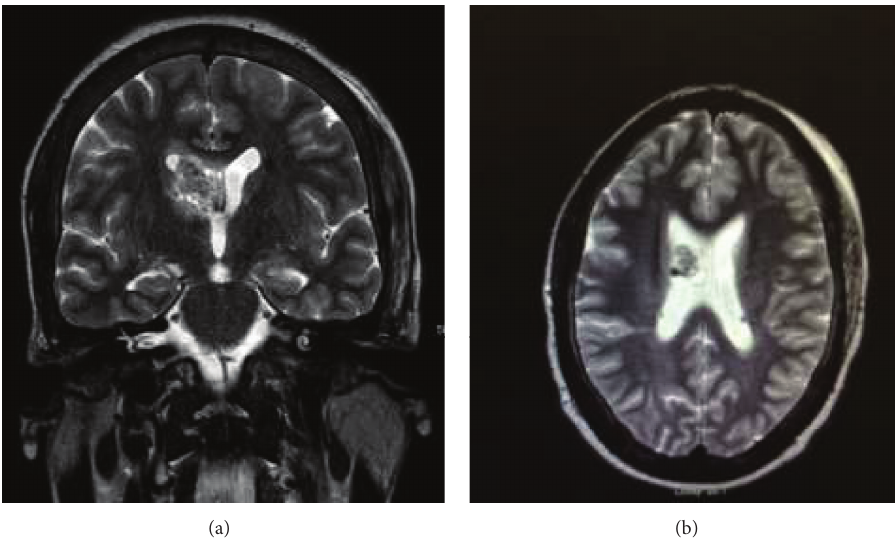
Figure 2: T2 weighted coronal (a) and axial (b) MRI showing 23 × 23 × 18 m lobulated mass in the right lateral ventricle and roof of the third ventricle which is isointense to grey matter and has small signal voids in keeping with calcifications.